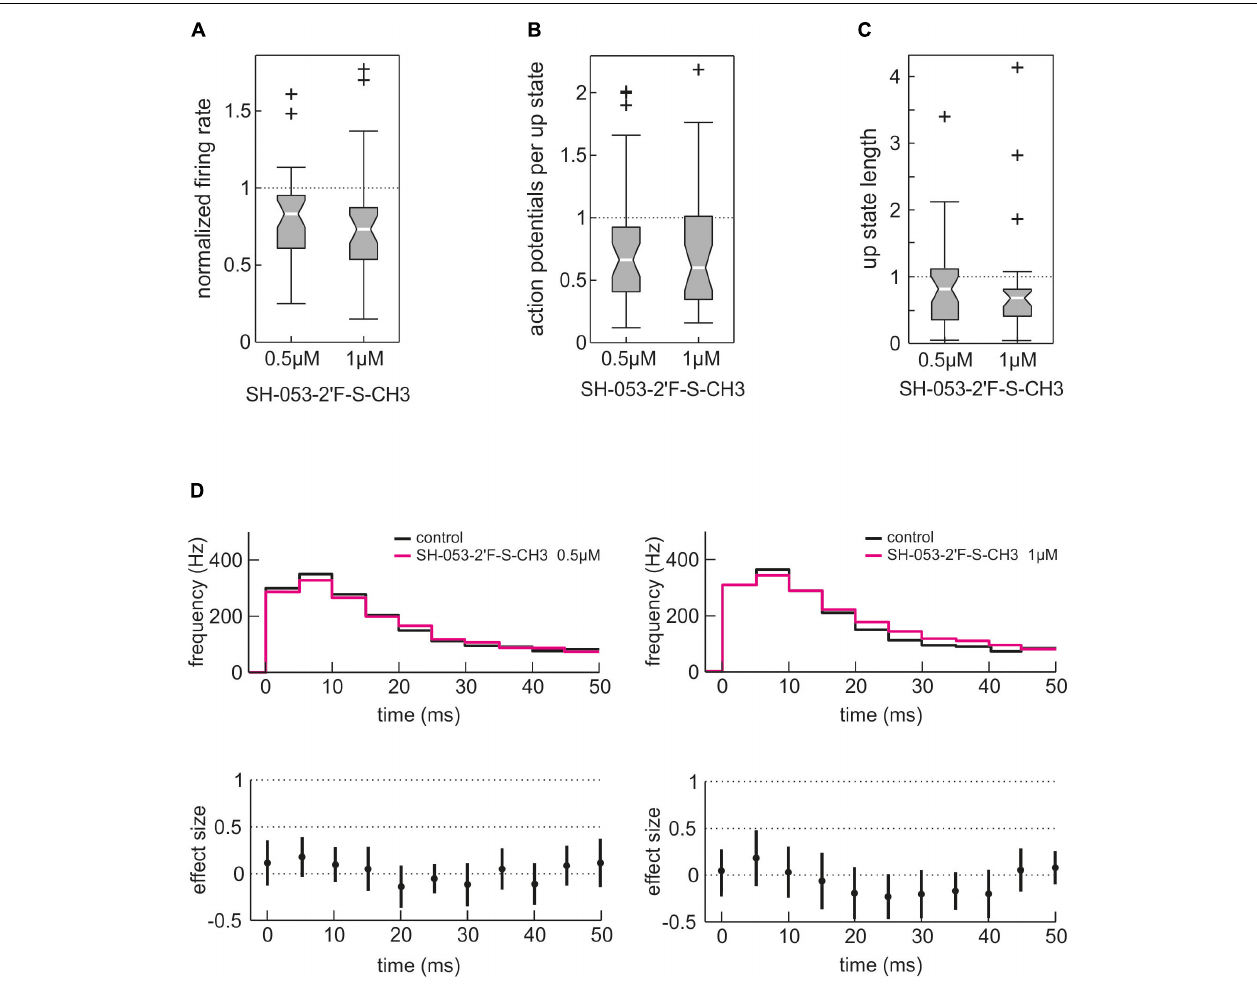
FIGURE 8 | Effect of the α 2/3/5 GABA A receptor-preferring experimental benzodiazepine SH-053-2 (cid:48) F-S-CH3 on cortical network activity. Unlike the α 1-subtype GABA A receptor-preferring zolpidem, SH-053-2 (cid:48) F-S-CH3 predominantly acts via α 2-, α 3-, and α 5-containing GABA A receptors. (A) Action of SH-053-2 (cid:48) F-S-CH3 (0.5 and 1.0 µ M) on overall neuronal activity given as boxplot. As expected from a benzodiazepine, SH-053-2 (cid:48) F-S-CH3 depressed cortical activity to 0.83 (median, iqr = 0.34, n = 37, p = 0.00025, Mann–Whitney U -test compared to control condition) at 0.5 µ M and to 0.73 of control activity (median, iqr = 0.34, n = 33, p = 0.0005, Mann–Whitney U -test compared to control condition) at 1.0 µ M. (B) Effect of SH-053-2 (cid:48) F-S-CH3 on the number of action potentials per up state. SH-053-2 (cid:48) F-S-CH3 reduced the number of action potentials per up state to 0.66 of control condition at 0.5 µ M (median, iqr = 0.52, n = 37, p = 0.0074, Mann–Whitney U -test) and to 0.60 at 1.0 µ M (median, iqr = 0.67, n = 33, p = 0.012, Mann–Whitney U -test). (C) Action of SH-053-2 (cid:48) F-S-CH3 on up state length. SH-053-2 (cid:48) F-S-CH3 reduced the median length of neuronal up states to 0.82 of control at 0.5 µ M (median, iqr = 0.76, n = 37, p = 0.0261, Mann–Whitney U -test) and to 0.68 (median, iqr = 0.40, n = 33, p = 0.0013, Mann–Whitney U -test compared to control condition) at 1.0 µ M. (D) The effects of 0.5 µ M ( n = 37) and 1.0 µ M ( n = 33) SH-053-2 (cid:48) F-S-CH3 on the first 50 ms of cortical up states are displayed as PETH, action of SH-053-2 (cid:48) F-S-CH3 in magenta versus control condition in black. Unlike zolpidem, SH-053-2 (cid:48) F-S-CH3 did not induce inhibition during phases of very high cortical activity (0 – 50 ms after the onset of cortical up states). At the higher concentration of 1.0 µ M, SH-053-2 (cid:48) F-S-CH3 even tended to induce a slightly higher neuronal activity between 20 and 40 ms after the beginning of the up state (see right lower part of the